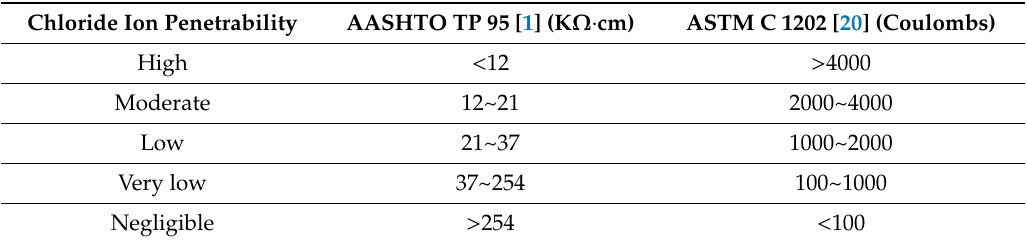
Table 2. Comparison of chloride penetrability levels established for standards based on electrical resistivity (AASHTO TP 95) and charged passed (ASTM C 1202).